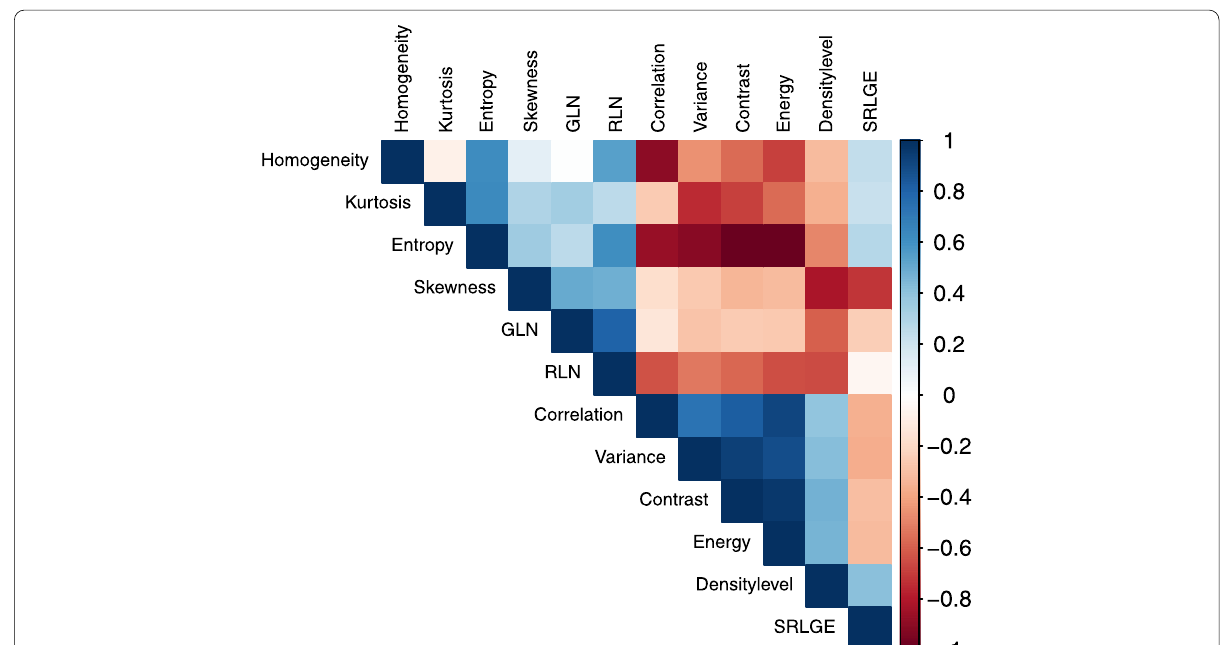
Fig. 4 Correlation matrix for the remaining 11 texture features, sorted by hierarchical order. GLN Grey-level nonuniformity, RLN Run-length nonuniformity, SRLGE Short-run low-grey-level